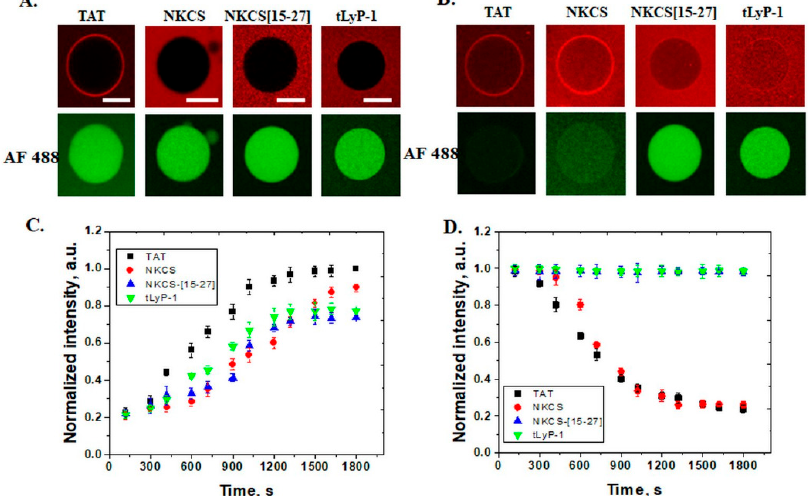
Figure 3. Internalization of peptides and efflux of Alexa Fluor 488 from POPE GUVs. Interaction of peptides (TAT, NKCS, NKCS-[15-27] and tLyP-1) with GUVs containing POPC/POPE/chol 50/30/20 mol% and release of AF 488, in the lower panel, ( A ) after 5 min and ( B ) after 30 min. ( C ) The time dependence of the normalized fluorescence intensity measured inside GUVs, for internalization of the four peptides (TAT ( (cid:4) ), NKCS ( • ), NKCS-[15-27] ( (cid:78) ) and tLyP-1 ( (cid:72) )) and ( D ) efflux of AF 488 tracer. Error bars indicate the standard deviation. Scale bars correspond to 15 µ